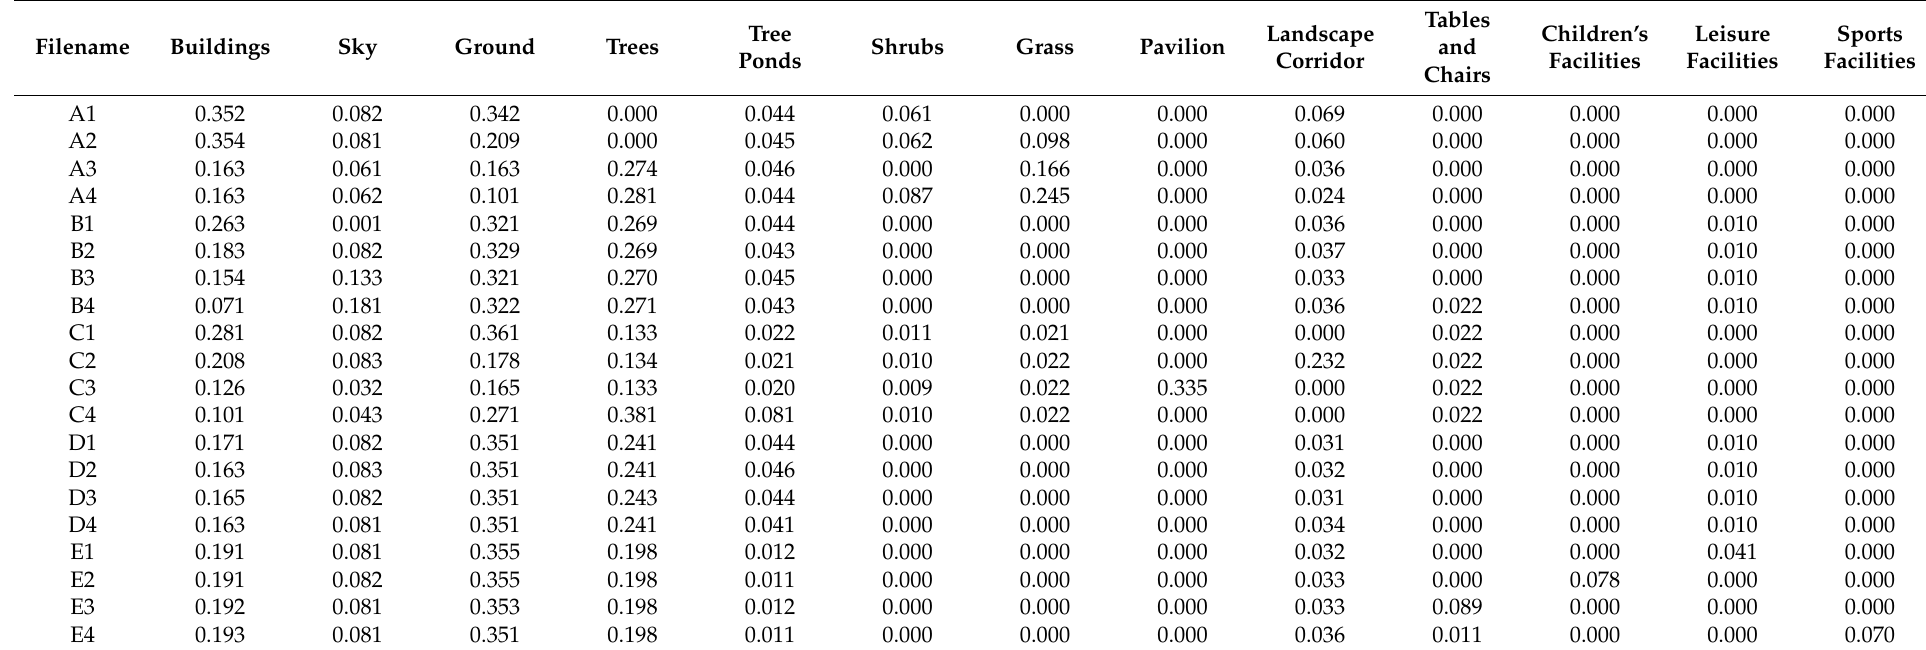
Table 4. Artificial Intelligence Convolutional Neural Network (CNN) Major Landscape Elements Recognition Output